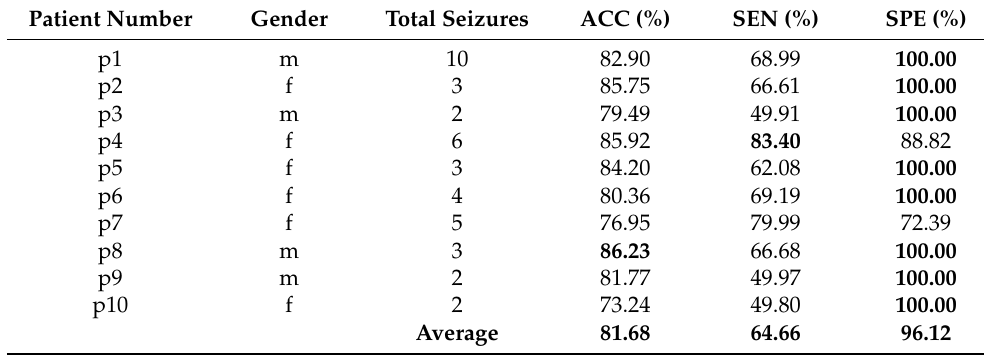
Table 2. RCV results for our data set. Bold format highlights maximum values.